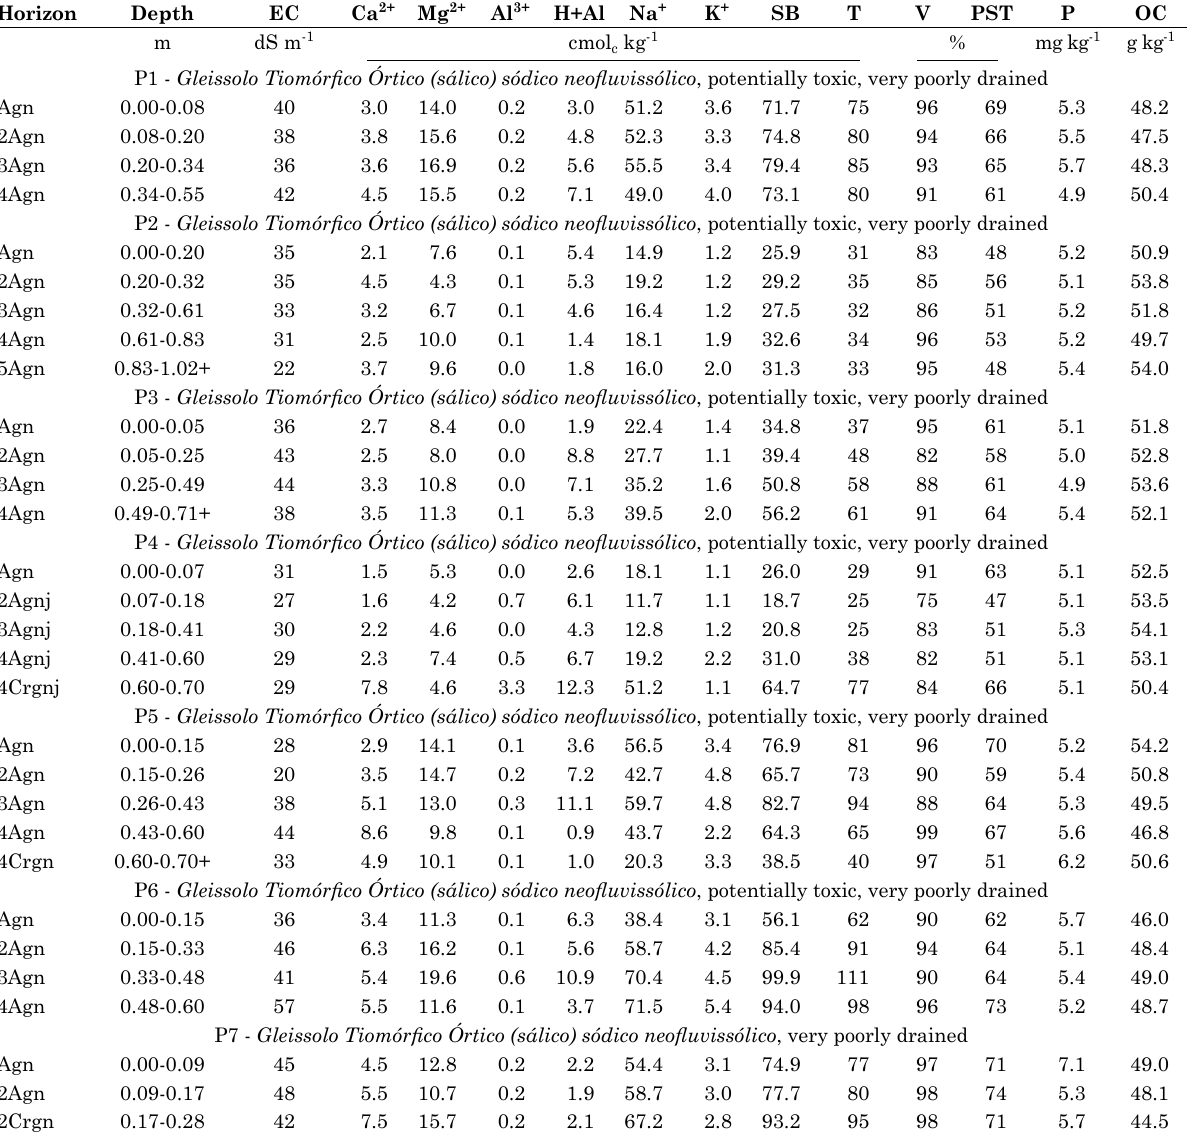
Table 3. Chemical properties of mangrove pedons of the Subaé river basin, Santo Amaro, Bahia, Brazil